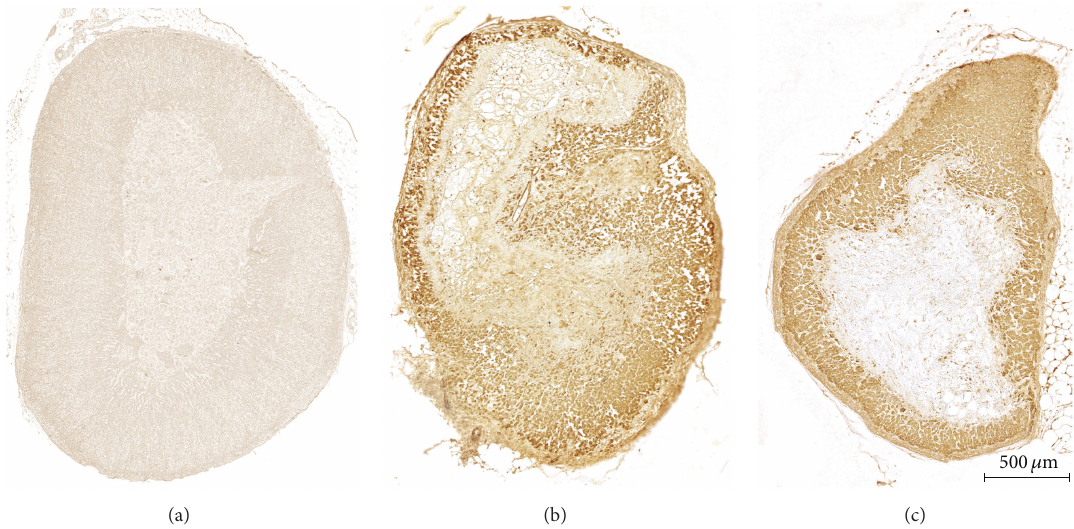
Figure 7: Cyclin B1-like immunoreactivity in regenerating rat adrenal cortex. Cytoplasmic staining of adrenocortical cells in regenerating glands: (b) day 3 and (c) day 5 of regeneration. (a) Adrenal of sham operated rat (counterstained with haematoxylin). Magnification defined by the scale